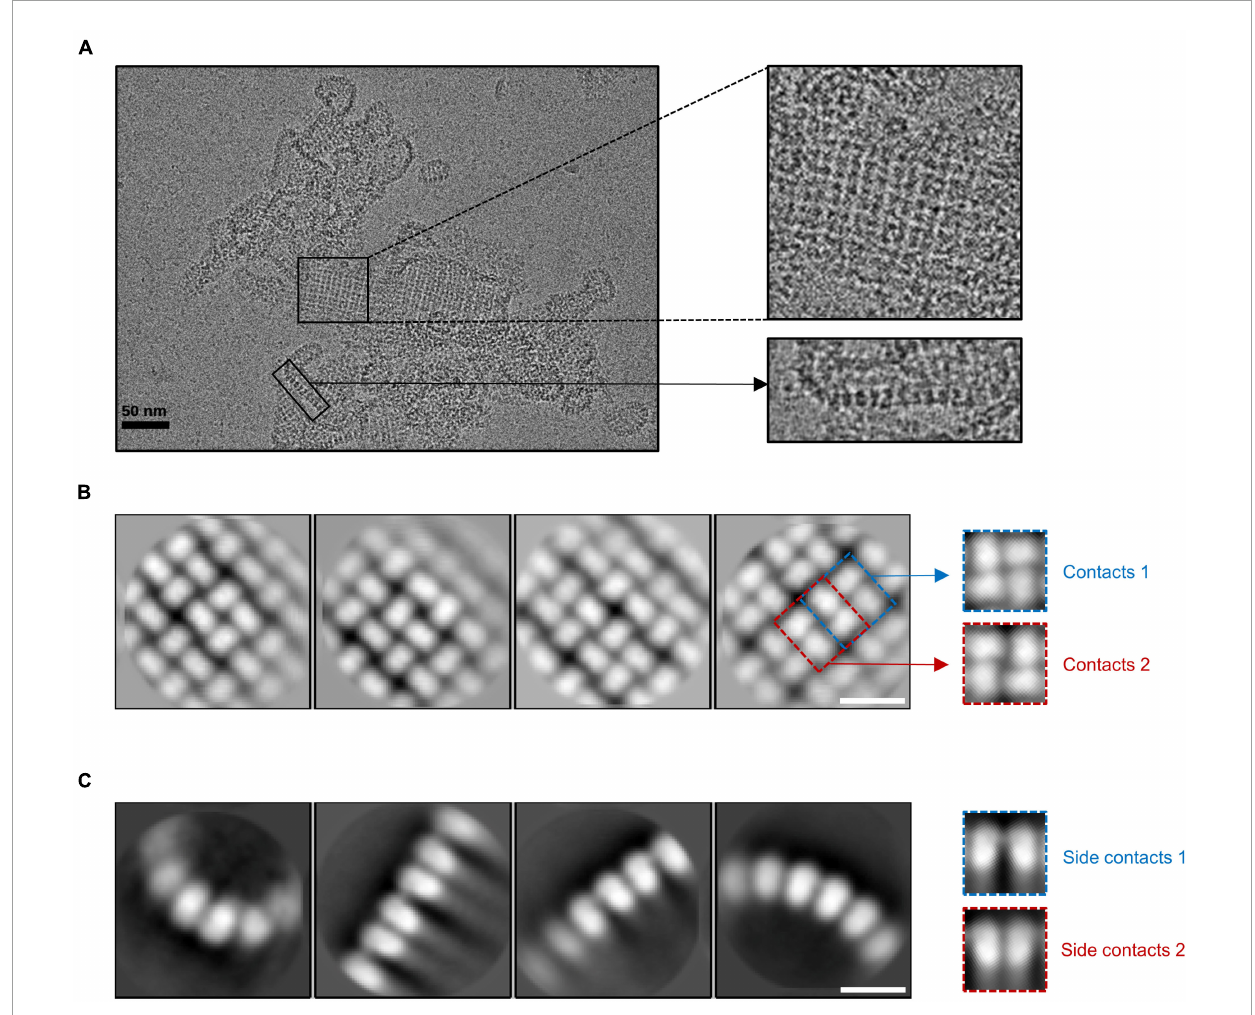
FIGURE1 The lattice-like structure of gp105. (A) A representative cryo-EM micrograph of the highly aggregated gp105 eluted at the void volume of the size exclusion chromatography (SEC). The insets showing the zoom-in pictures of the central part and edge part, respectively. (B,C) 2D class averages of the highly aggregated gp105 eluted at the void volume of SEC. The averaged images of the particles located in the aggregates showing the top view of the assembly (B) . The averaged images of the particles located at the edge of the aggregates showing the side view of the assembly (C) . The scale bars represent 10